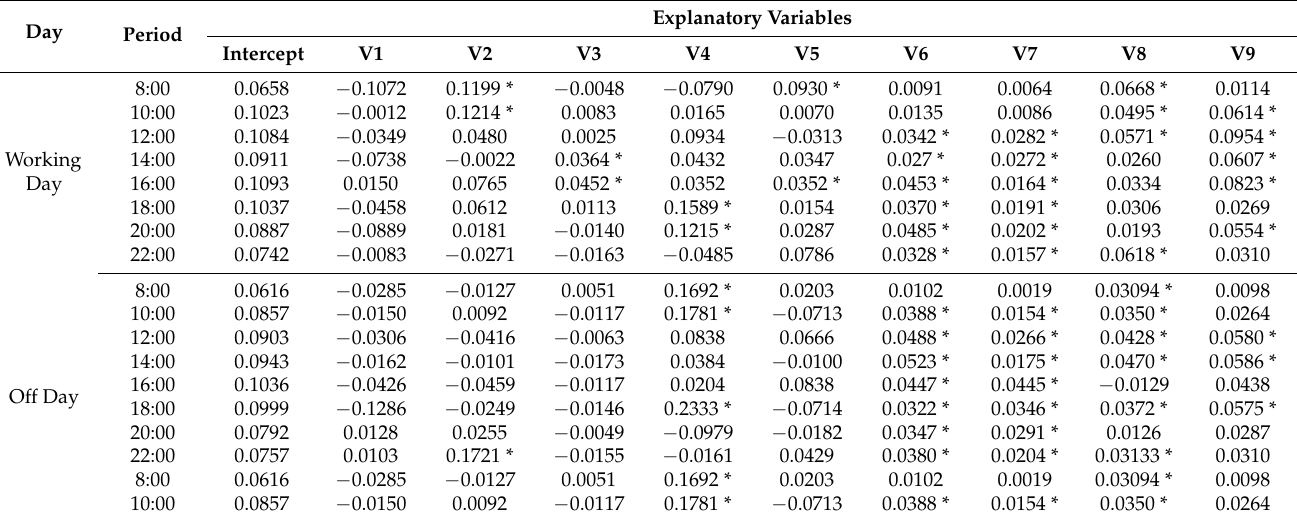
Table 6. The OLS regression results for the XZZX station realm.